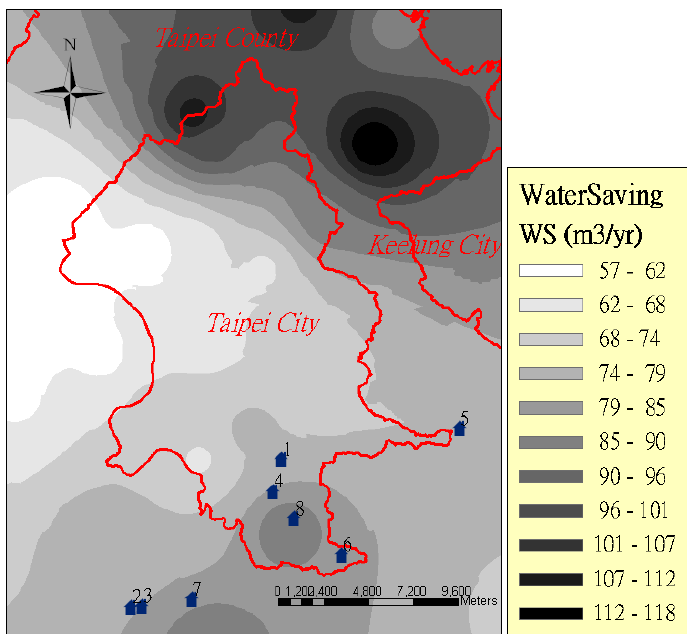
Figure 3. The locations of the communities, and the spatial variation of WS (m 3 /year) (assuming A = 90 m 2 , V = 3 m 3 ) per household and rainwater used for toilet flushing and gardening.